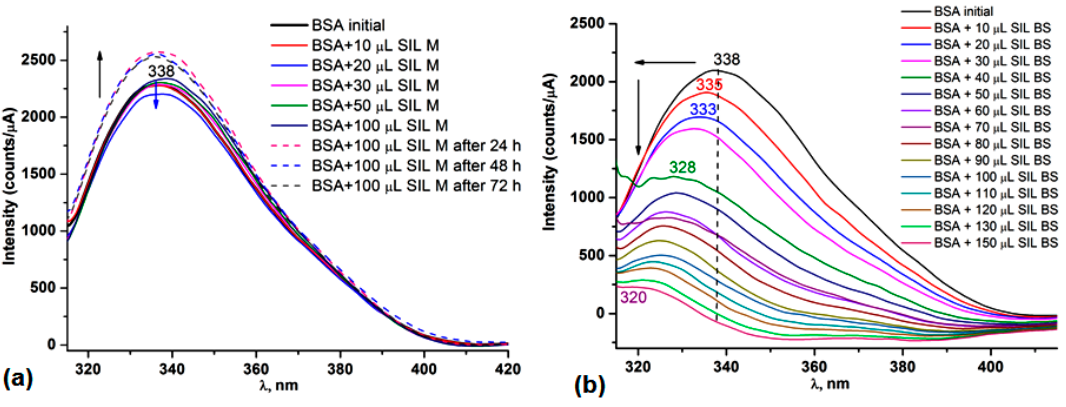
Figure 5. Emission spectra of the protein (BSA) during and after titration with SIL M ( a ) and SIL-BS ( b ) solutions 10 ‒ 3 M. ( b ) solutions 10 − 3